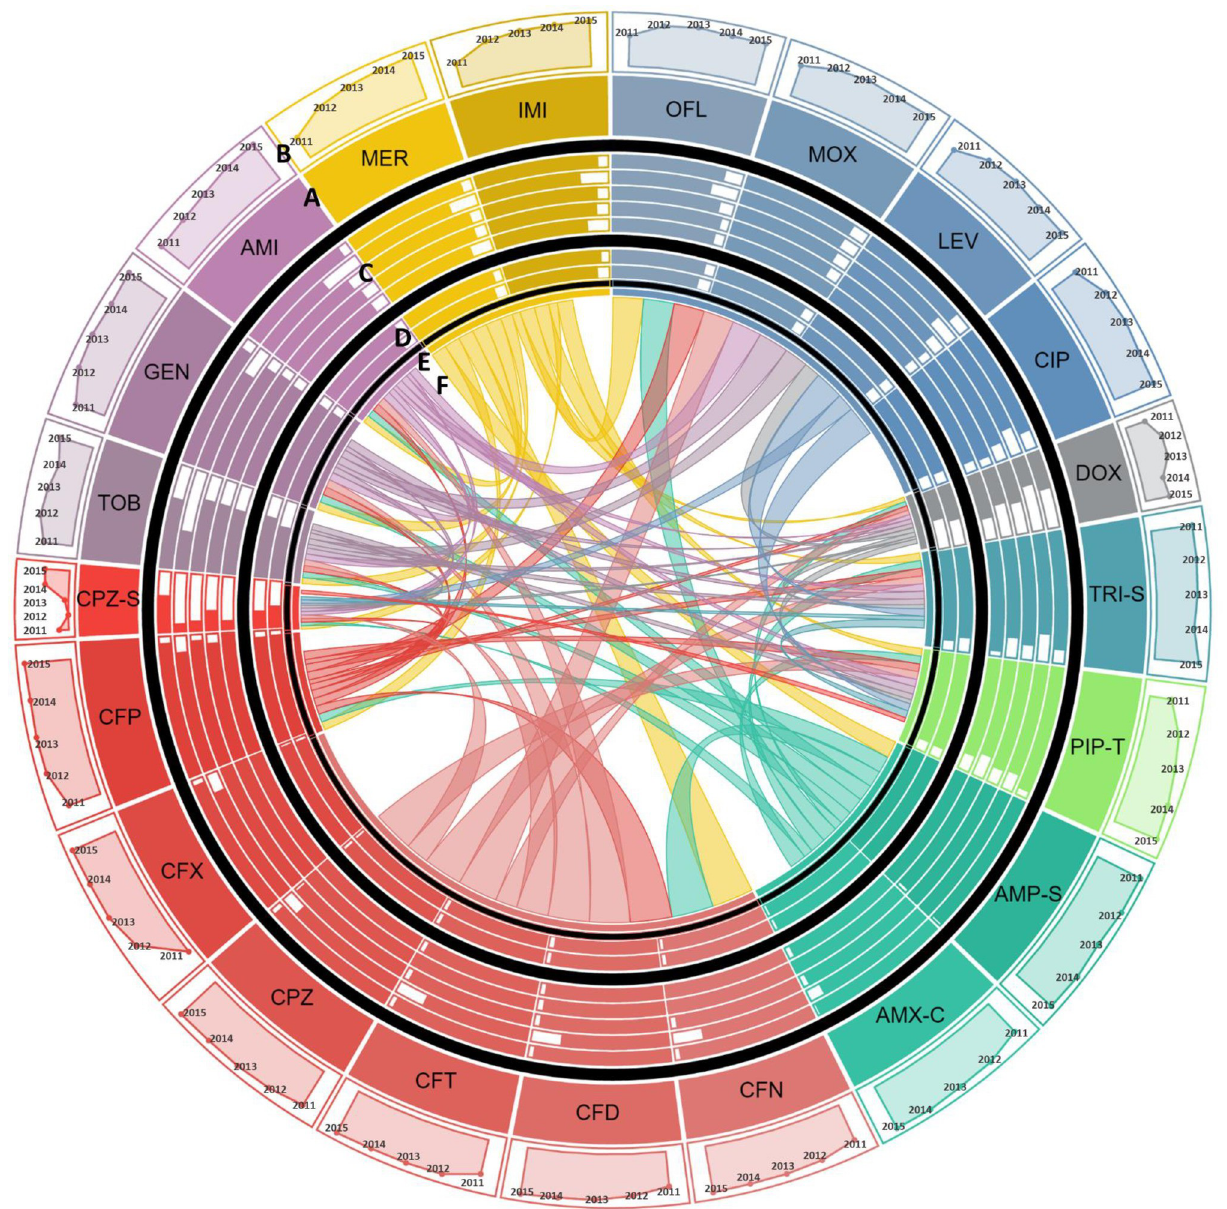
Fig 3. Antimicrobial resistance in Acinetobacter . A: Each section of the diagram represents the resistance observed in Acinetobacter species against the antibiotic. Size of each section is proportional to the proportion of Acinetobacter species resistant to the antibiotic over the study period. Antibiotics of the same class are shown in similar colors. B: Line graphs show temporal trends of proportion of resistant Acinetobacter species in a clockwise direction from 2011 to 2015. C: Bar charts show the comparison of susceptibility to resistant isolates in patients of different age groups. Moving from out to inward, bars represent proportion of resistant Acinetobacter species reported in children < 5 years of age, young adults between 6 to 18 years, middle aged 19 to 45 years old, 45 to 65 years old patients, and elderly over 65 years of age, respectively. D: Gender-wise comparison to susceptibility to resistant Acinetobacter species is shown in form bars. Outer circle and inner circle shows proportion of resistant Acinetobacter species isolated from women vs. men, respectively. E: For co-resistance analysis, antibiotics belonging to the same class with same susceptibility profile for all isolates of E . coli were merged into a single variable. F: Proportion Acinetobacter species isolates resistant to one antimicrobial resistant to another antimicrobial are shown in the connections. The area covered by the connection on E is proportional to the level of co-resistance observed. Co-resistance proportions were scaled down to 1/10 th of the actual overlap for visualization. Abbreviations: DOX: Doxycycline, TRI-S: Trime-Sulphamethoxazole, PIP-T: Piperacillin-Tazobactam, AMP-S: Ampicillin-Sulbactam, AMX-C: Amoxicillin-Clavulanic acid, CIP: Ciprofloxacin, LEV: Levofloxacin, OFL: Ofloxacin, MOX: Moxifloxacin, CFN: Ceftriaxone, CFD: Ceftazidime, CFT: Cefotaxime, CPZ: Cefoperazone, CFX: Cefixime, CFP: Cefepime, CPZ-S: Cefoperazone-Sulbactam, IMI: Imipenem, MER: Meropenem, TOB: Tobramycin, GEN: Gentamicin, and AMI: Amikacin.